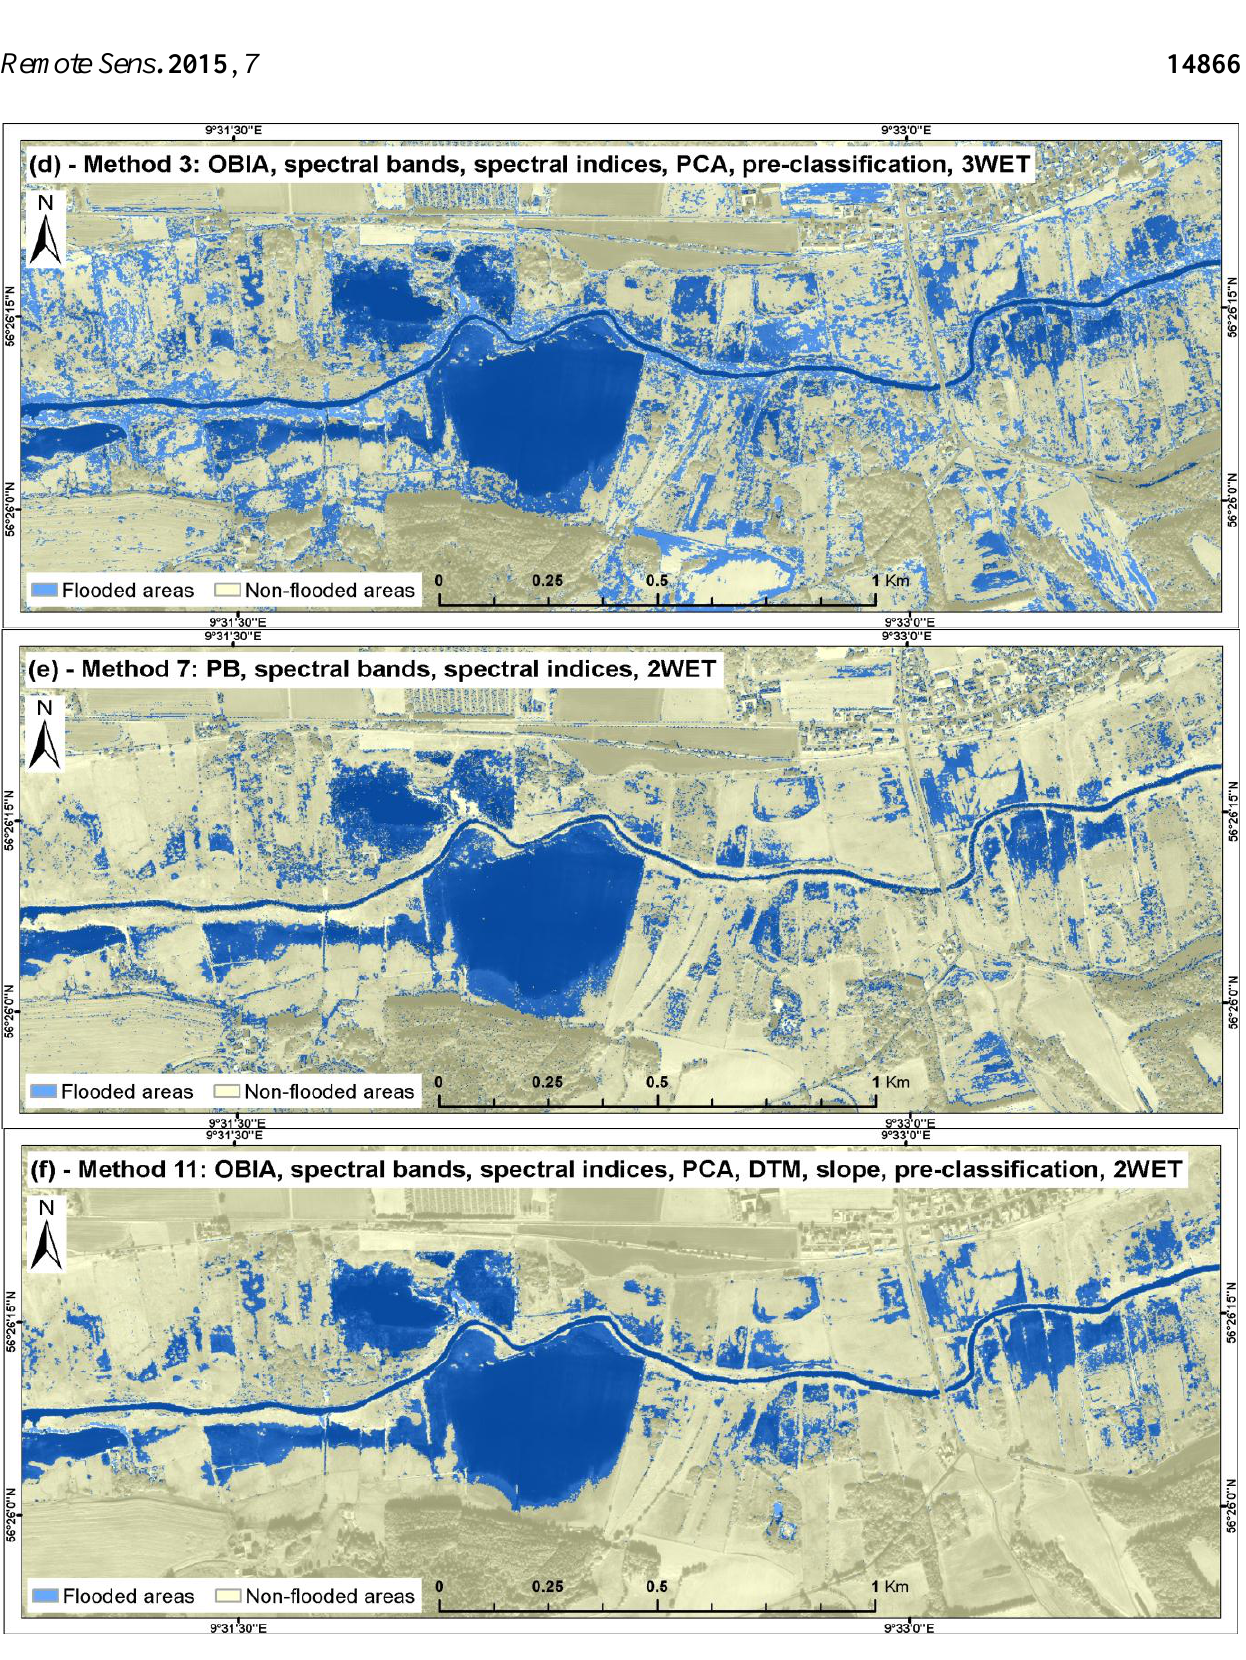
Figure 7. WorldView-2 image of the study area presented in natural colors ( a ); and selected maps of localized flooding resulting from the classification methods developed in the study ( b – f ) and described in Table 3. The flooding maps are superimposed on the WV2 panchromatic